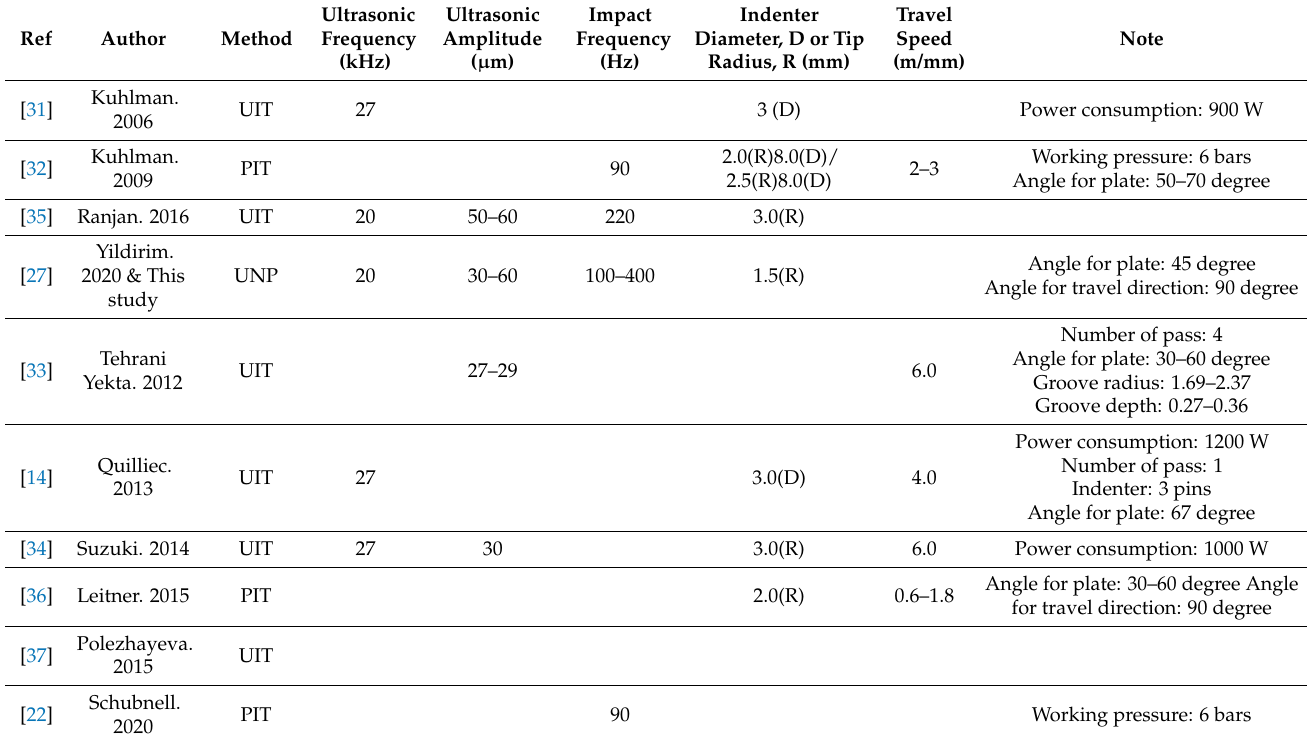
Table A2. Detailed information of literature on HFMI treatment